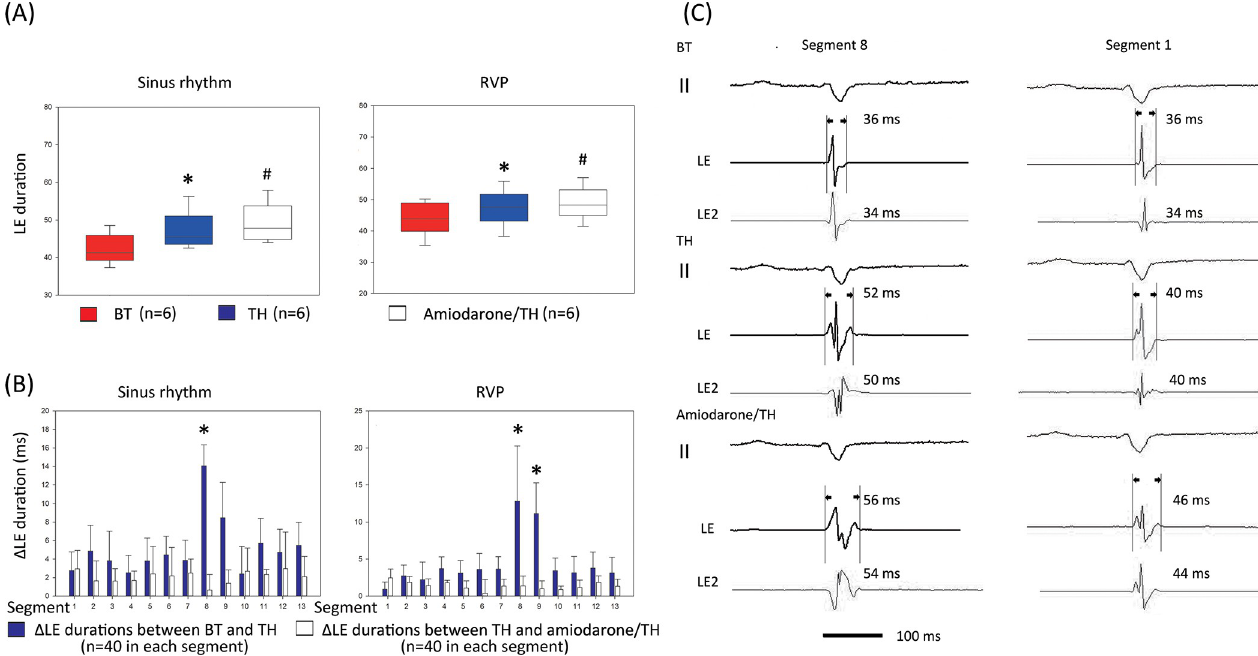
Fig 4. Global and regional changes in the LE duration. (A) Sequential changes in the LE duration after TH or amiodarone treatment during SR or RVP. These data were derived from all the six pigs from this study. A sequential reduction in the LE durations was observed after TH or amiodarone treatment. * P < 0.05, BT vs. TH; # P < 0.05, TH vs. Amiodarone/TH, both by the paired t-test. (B) Interval changes between BT and TH ( Δ LE durations between BT and TH) and between TH and amiodarone/TH ( Δ LE durations between TH and amiodarone/TH) in the different epicardial segments. These data were derived from all the six pigs from this study. The interval changes in the LE durations in segment 8 (anterior mid RV or posterior mid RV) were significantly greater than those in all the other segments. * P < 0.05, Δ LE durations between BT and TH in segment 8 or segment 9 vs. the other segments in the post-hoc analysis with the Bonferroni method. (C) Representative bipolar electrograms of segment 8 and segment 1 from pig 4 during BT, TH, and amiodarone/TH demonstrating sequential prolongation of the LE durations.